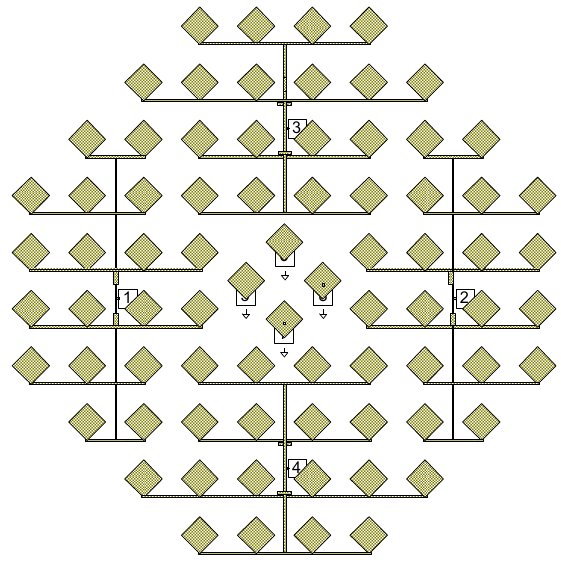
Fig. 1. The layout of the proposed antenna